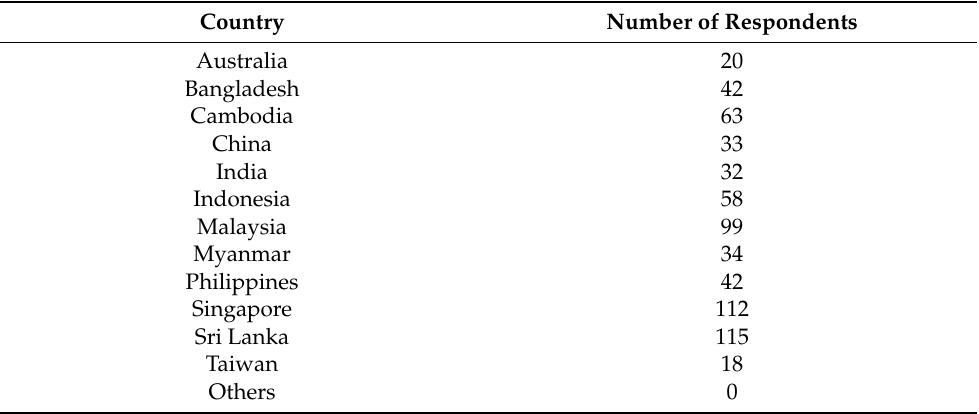
Table 7. The preference of the country of origin of mud crabs that participants chose to eat.